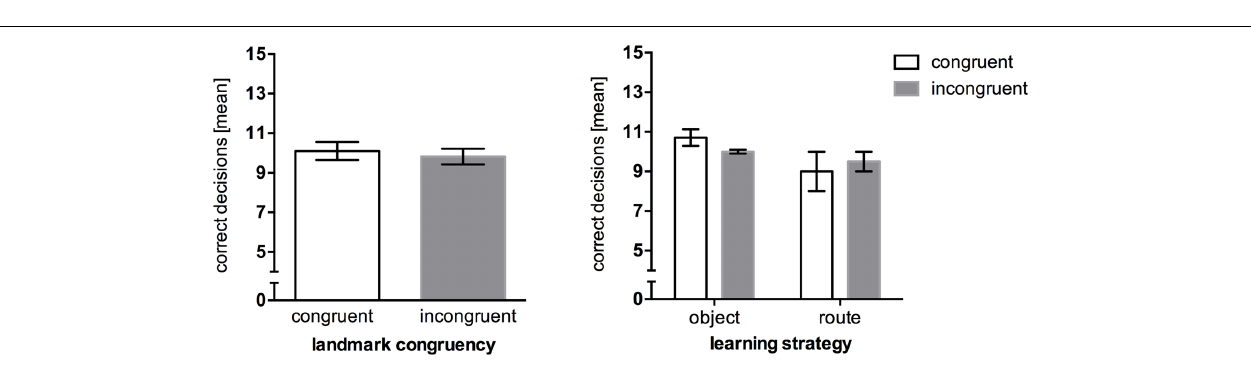
FIGURE 2 | Results of Experiment 1, error bars represent the SEM . (Left) Mean correct route decisions of the wayfinding task (chance level = 5). (Right) Mean correct answers of the recognition task (chance level = 15).